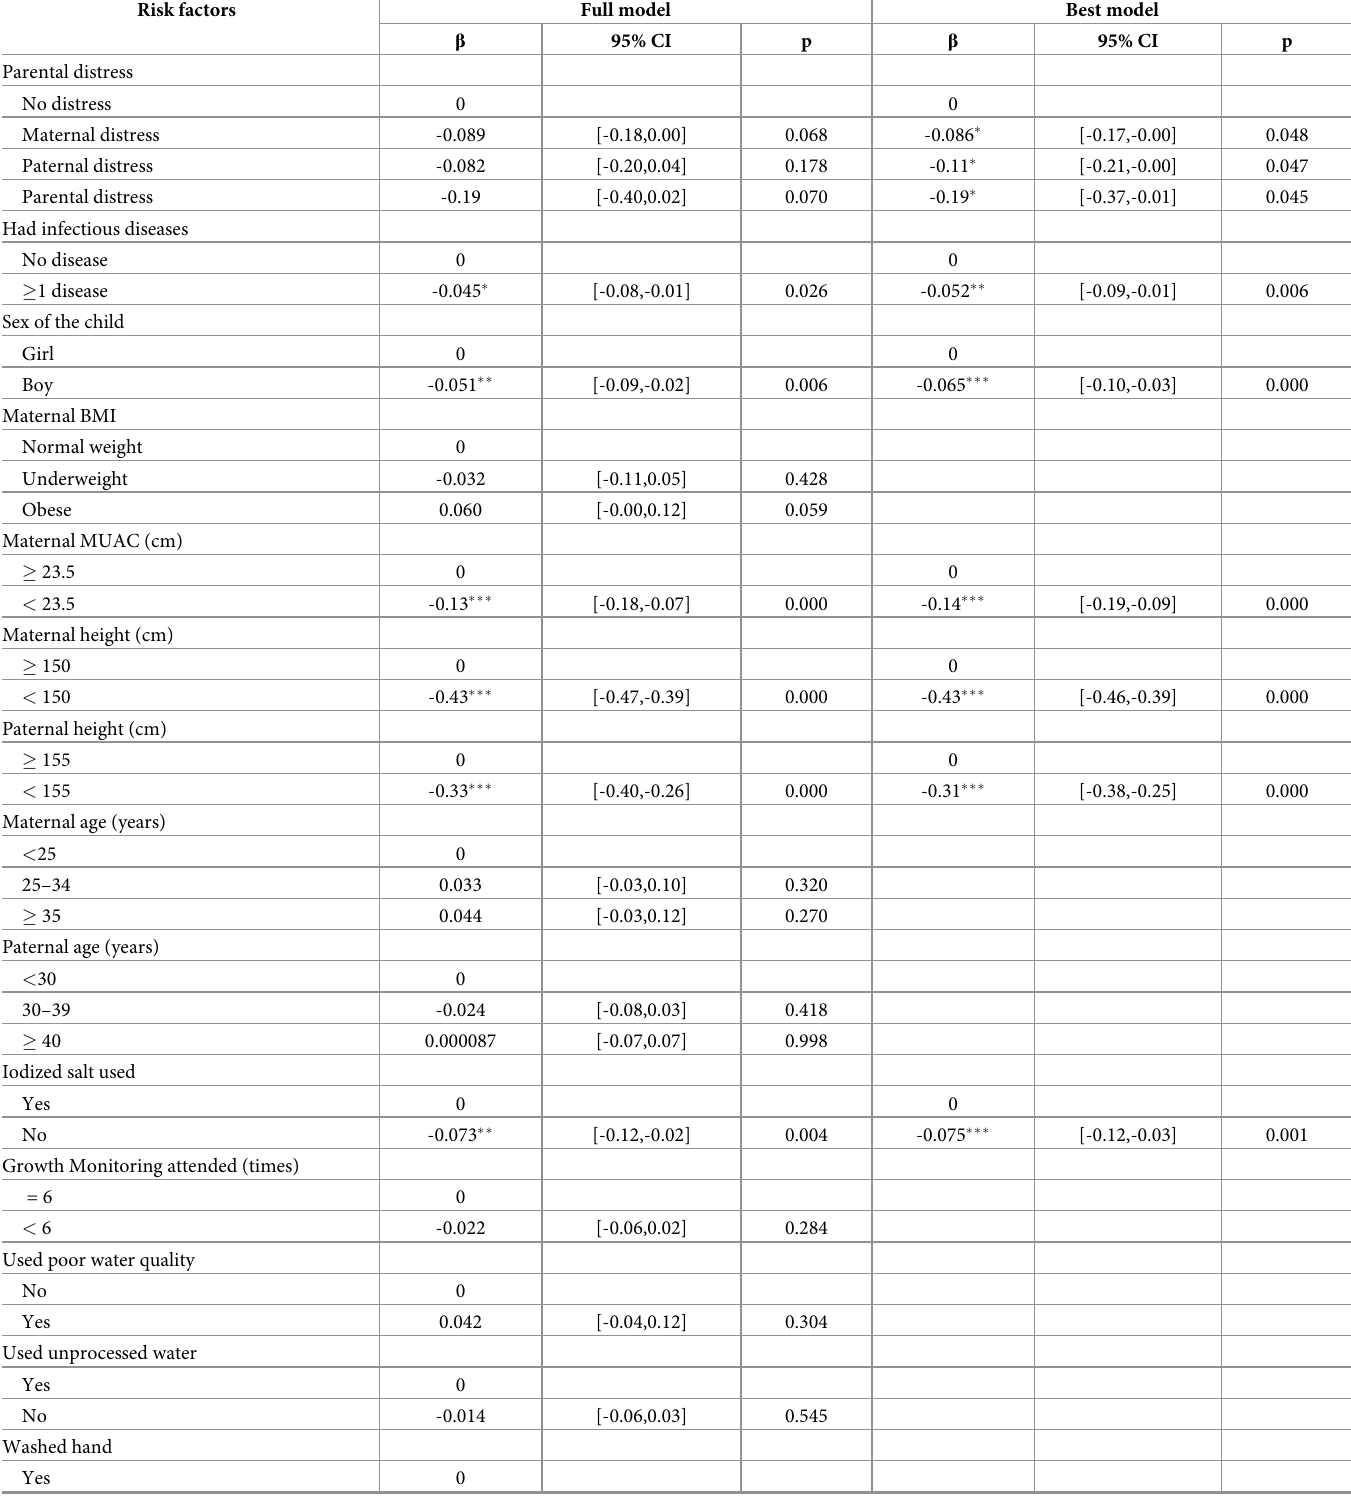
Table 2. Regression coefficient of distress of parents and other risk factors for child